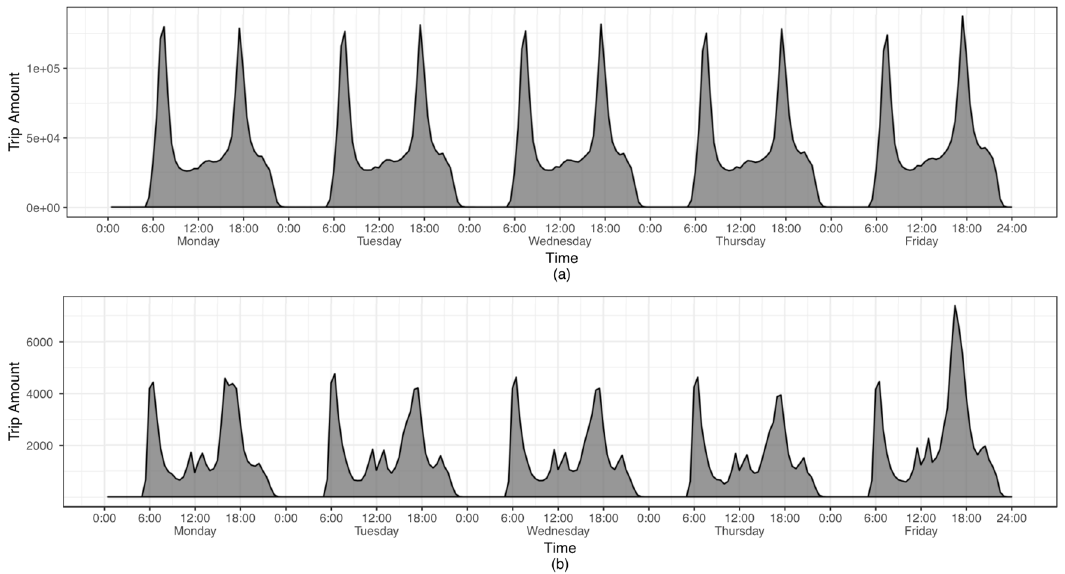
Figure 6. The counts of trips for all travellers ( a ) and students ( b ) over five weekdays. The x -axis indicates half hour intervals, and the y -axis indicates the number of trips per 30 minutes.